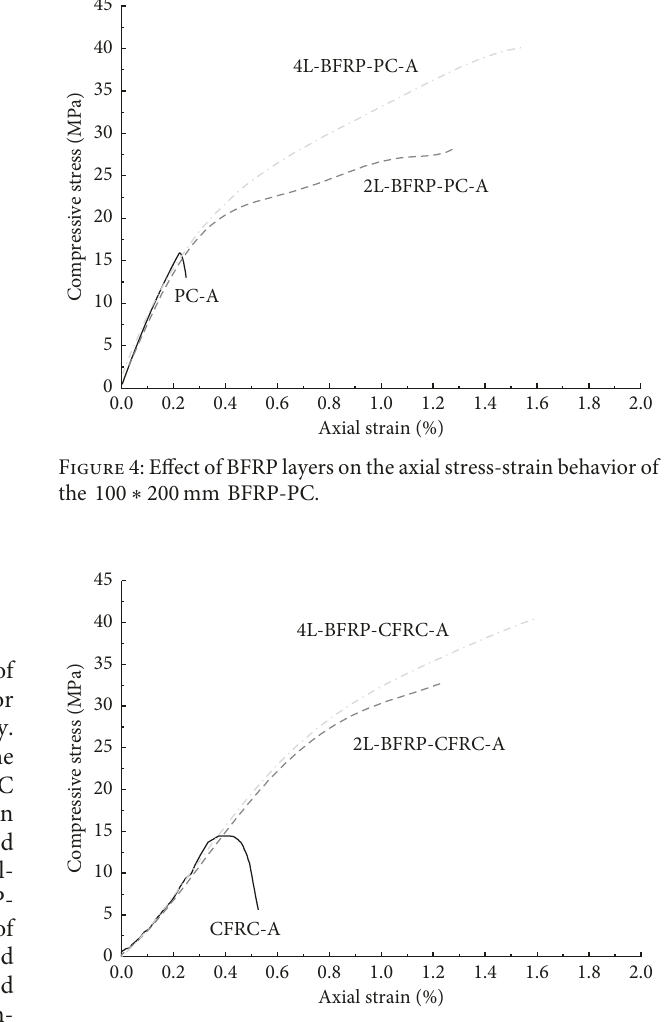
Figure 5: Effect of BFRP layers on the axial stress-strain behavior of the 100 ∗ 200mm